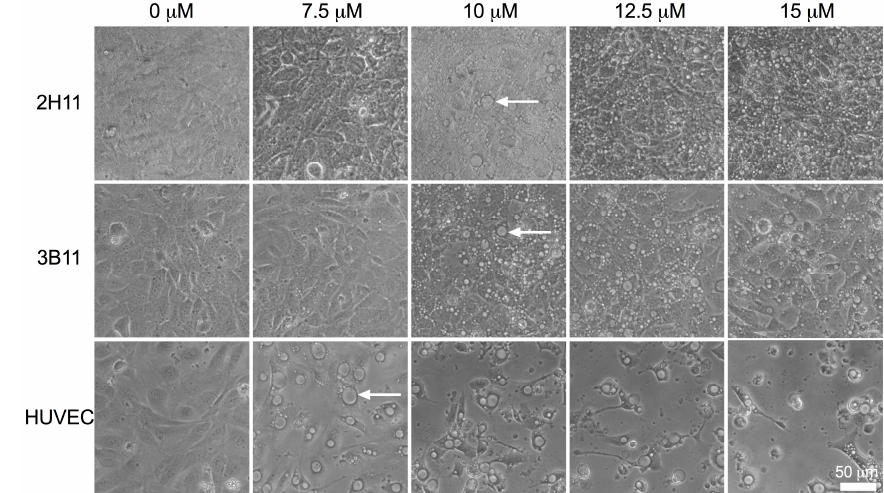
Figure 4. Endothelial cells treated with bacopaside II formed intracellular vacuoles. Endothelial cells following 20 h-treatment with various concentrations of bacopaside II. Vacuoles appeared at 10 μ M for 2H11 and 3B11 and at 7.5 μ M for HUVECs as indicated by white arrows. (200× magnification, scale bar = 50 μ m).